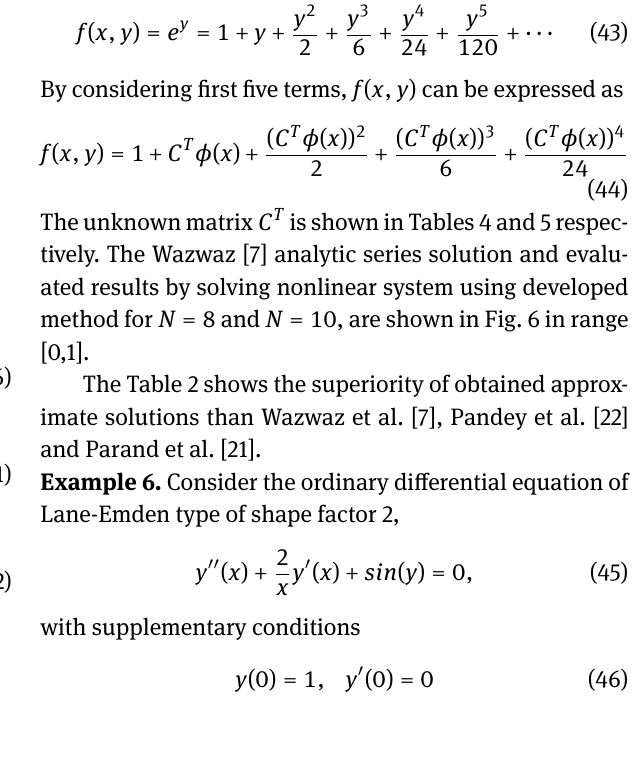
y ( x ) = C T ϕ ( x ) and f ( x , y ) = e y